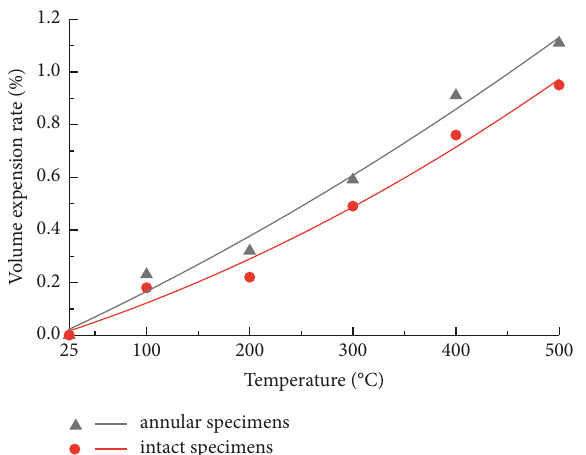
Figure 3: Volume expansion rate of samples after different temperatures.